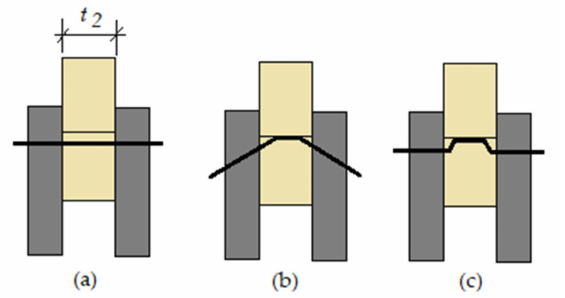
Figure 2. Timber-to-timber connections in double shear (W-W-W): ( a ) bearing failure of the edge members; ( b ) central member bearing failure; ( c ) plastic hinge on the fastener inside the central member and bearing failure of all the members; ( d ) plastic hinges on the fastener and bearing failure on all members.